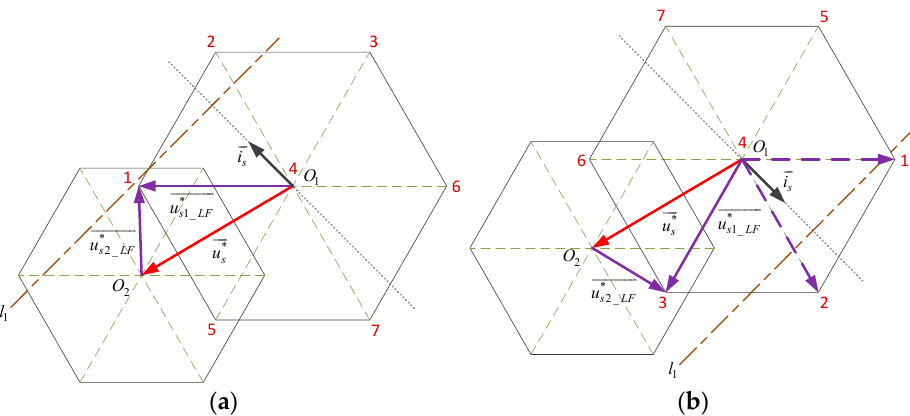
Figure 6. Voltage vector distribution examples of low switching frequency method. ( a ) First situation; ( b ) second situation.